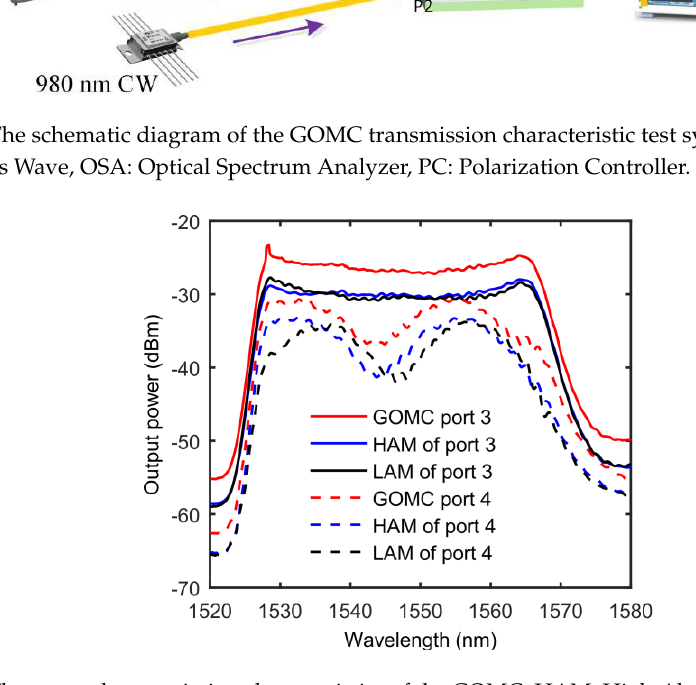
Figure 4. The spectral transmission characteristics of the GOMC. HAM: High-Absorption-Loss Mode, LAM: Low-Absorption-Loss Mode.